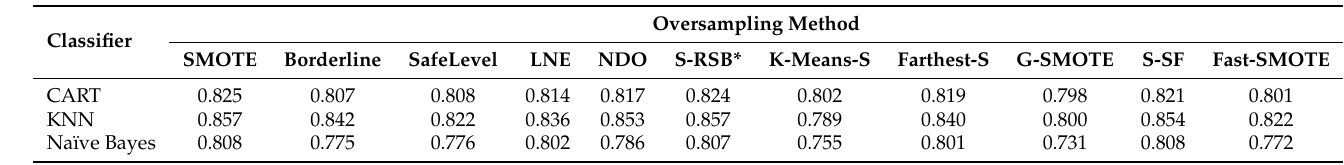
Table 3. Average AUC results of CART, KNN and Naive Bayes classifiers for the 66 datasets from the KEEL repository.